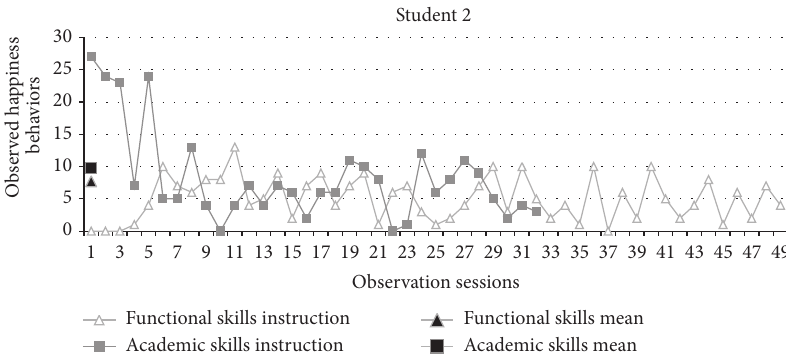
Figure 3: Total frequency of behaviors associated with happiness per observation session for Student 2.